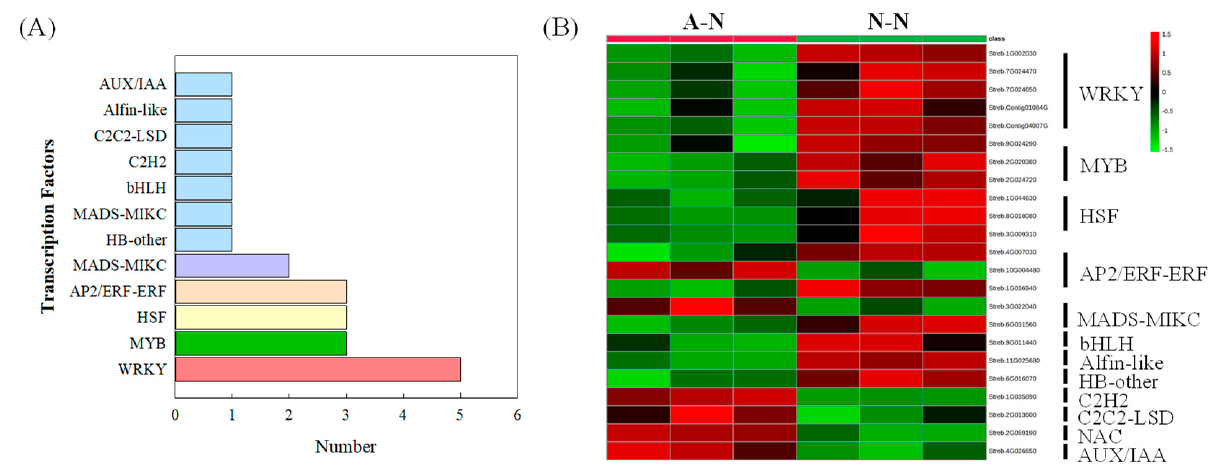
Figure 6. Transcription factors identified from the DEGs between ammonium (A-N)- and nitrate (N-N)-treated stevia ( A ) and a heatmap showing their expression profiles ( B ).